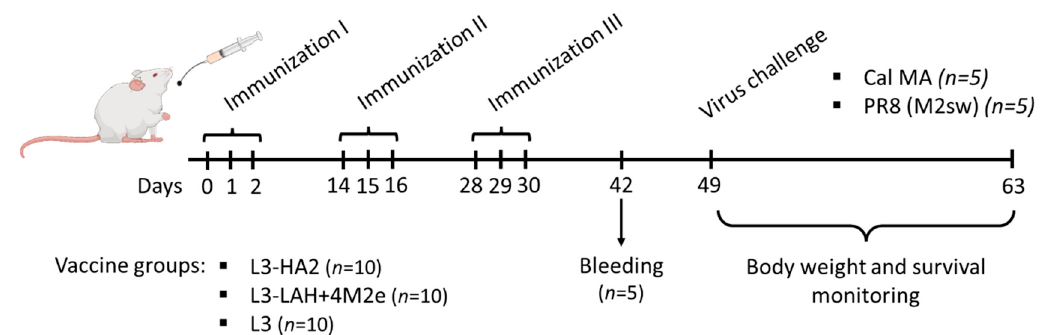
Figure 1. Overview of the mouse study design. BALB/c mice ( n = 30) were immunized three times by feeding with a corresponding vaccine (L3-HA2, L3-LAH+4M2e or L3), two weeks apart. Serum samples were collected from retro-orbital sinus from five mice on Day 42 for immunological assessment. On Day 49, the mice were challenged with 3 LD 50 of either mouse-adapted A/California/7/09 strain or a recombinant A/PR8-based virus carrying M gene of swine-origin lineage. Protection was assessed by monitoring weight loss and survival for 14 days post challenge.